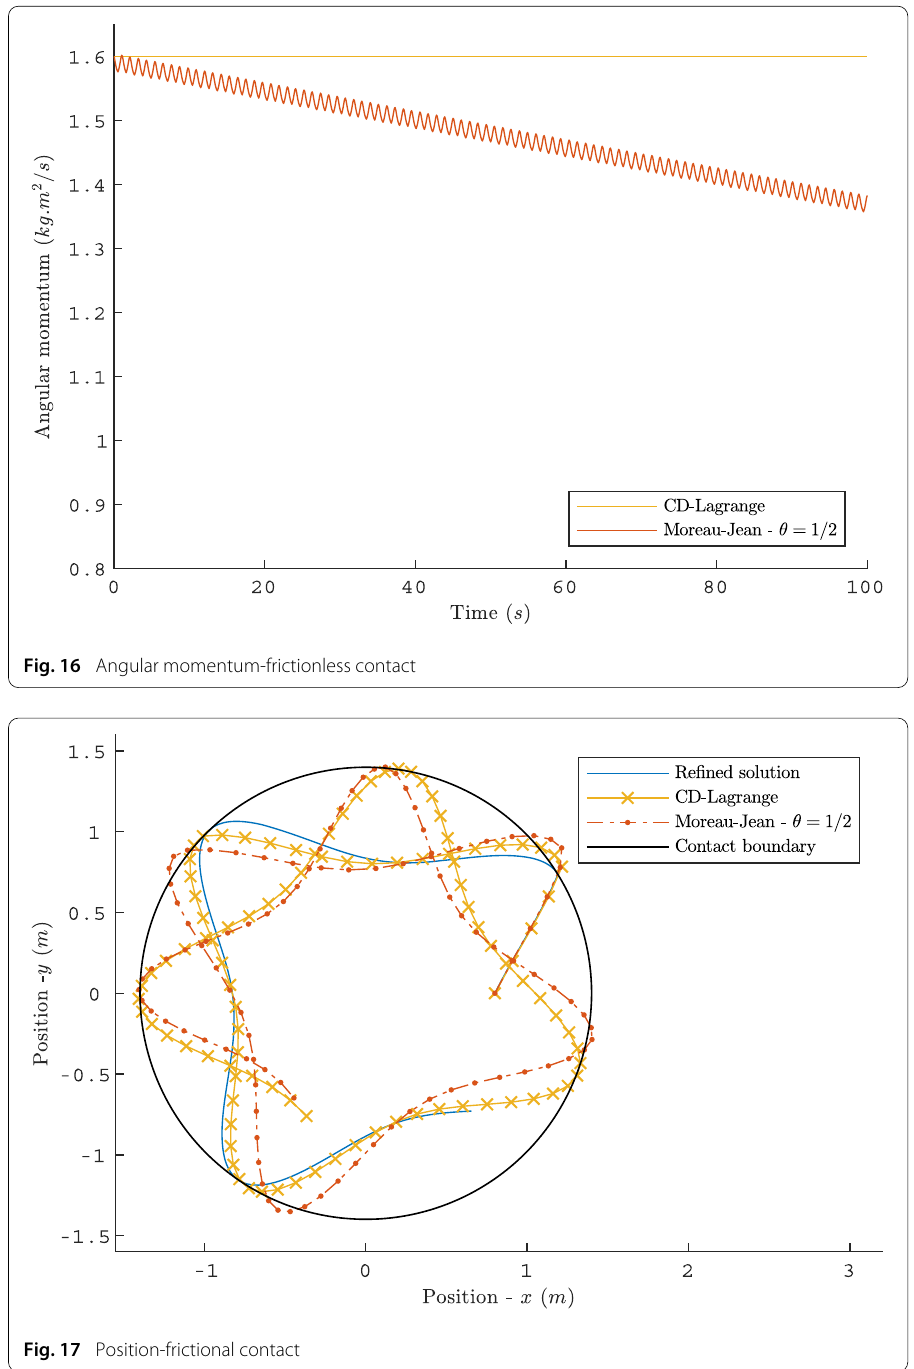
the angular momentum being parallel to position vector. But for Moreau–Jean’s scheme the angular momentum oscillates and decreases (more than 10% of its initial value over 100 s) as shown by Fig. 16. The conservation of angular momentum is achieved only at convergence. For CD-Lagrange the angular momentum is exactly conserved to its initial value illustrating the symplectic